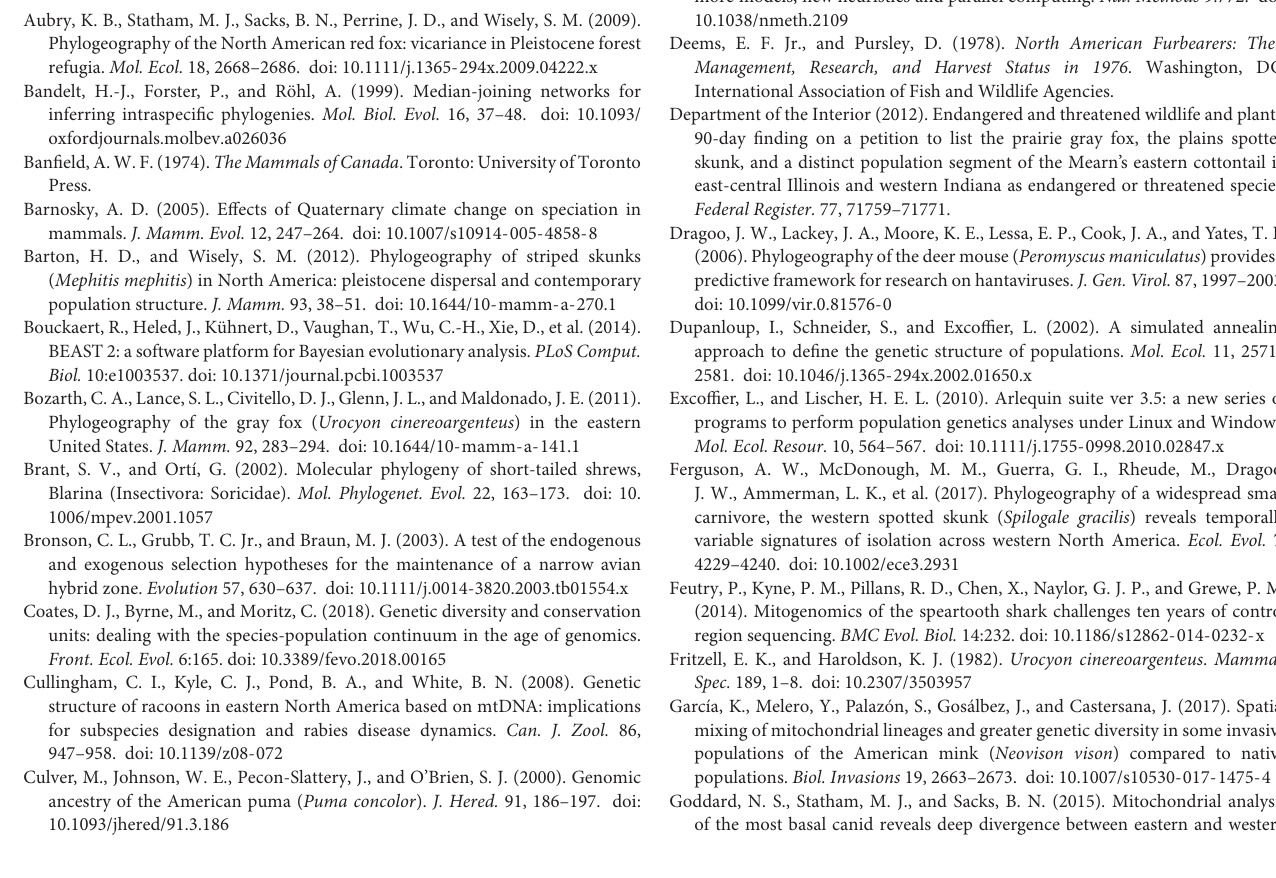
Supplementary Figure 3 | Results of SAMOVA for (A) 19 East and (B) 12 West Urocyon sample groups ( n > 10) based on 400 bp of mtDNA control region. Supplementary Figure 4 | Relationship between pairwise geographic distance and genetic distance for East ( n = 19) and West ( n = 12) Urocyon sample groups based on 400 bp of mtDNA control region. Supplementary Figure 5 | MrBayes subtrees for (A) West haplotypes and (B) East haplotypes based on the analysis of 104 unique Urocyon mitogenome haplotypes and two outgroups ( Vulpes vulpes and Canis latrans , removed for clarity). Support for clades (BPP) is shown next to each node. Urocyon sample names reflect species (Uc = U. cinereoargenteus ; Ul = U. littoralis ), morphologically-based subspecies, location (state or island), and sample ID or GenBank accession number, and colors correspond to identified major clades. Maps show the ranges of morphologically-based subspecies, and the sampling locations of the mitogenomes are depicted as colored dots corresponding to major clade (as shown in the tree). Supplementary Table 1 | Results of SAMOVA for 19 East and 12 West Urocyon sample groups ( n > 10) based on 400 bp of mtDNA control region. Supplementary Appendix 1 | An Excel file containing information about the samples used in this study. Supplementary Alignment 1 | Fasta alignment file for mtDNA partial control region